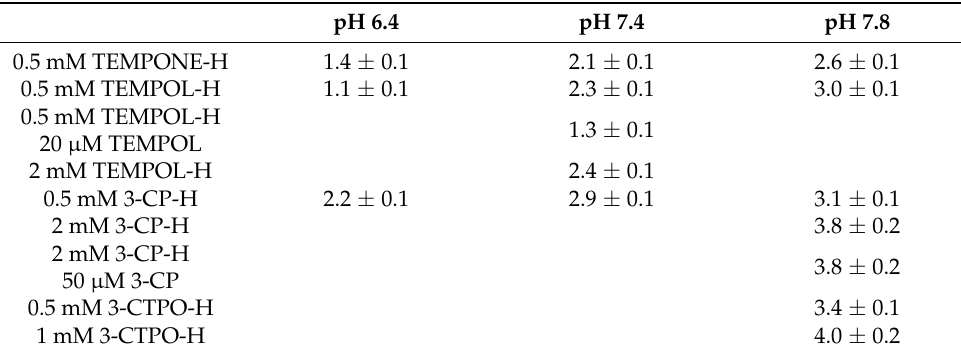
Table 2. Initial rate ( µ M/min) of RNO • accumulation upon irradiation of oxygenated solutions containing RNO-H, 0.1 M formate, 10 mM phosphate and 50 µ M DTPA producing a flux of 4.0 ± 0.1 µ M/min superoxide.